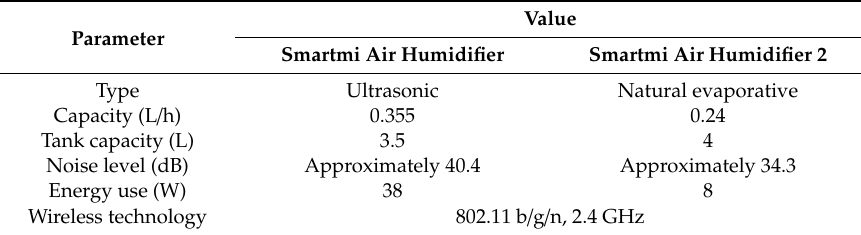
Table 2. Specifications of two types of humidifiers.